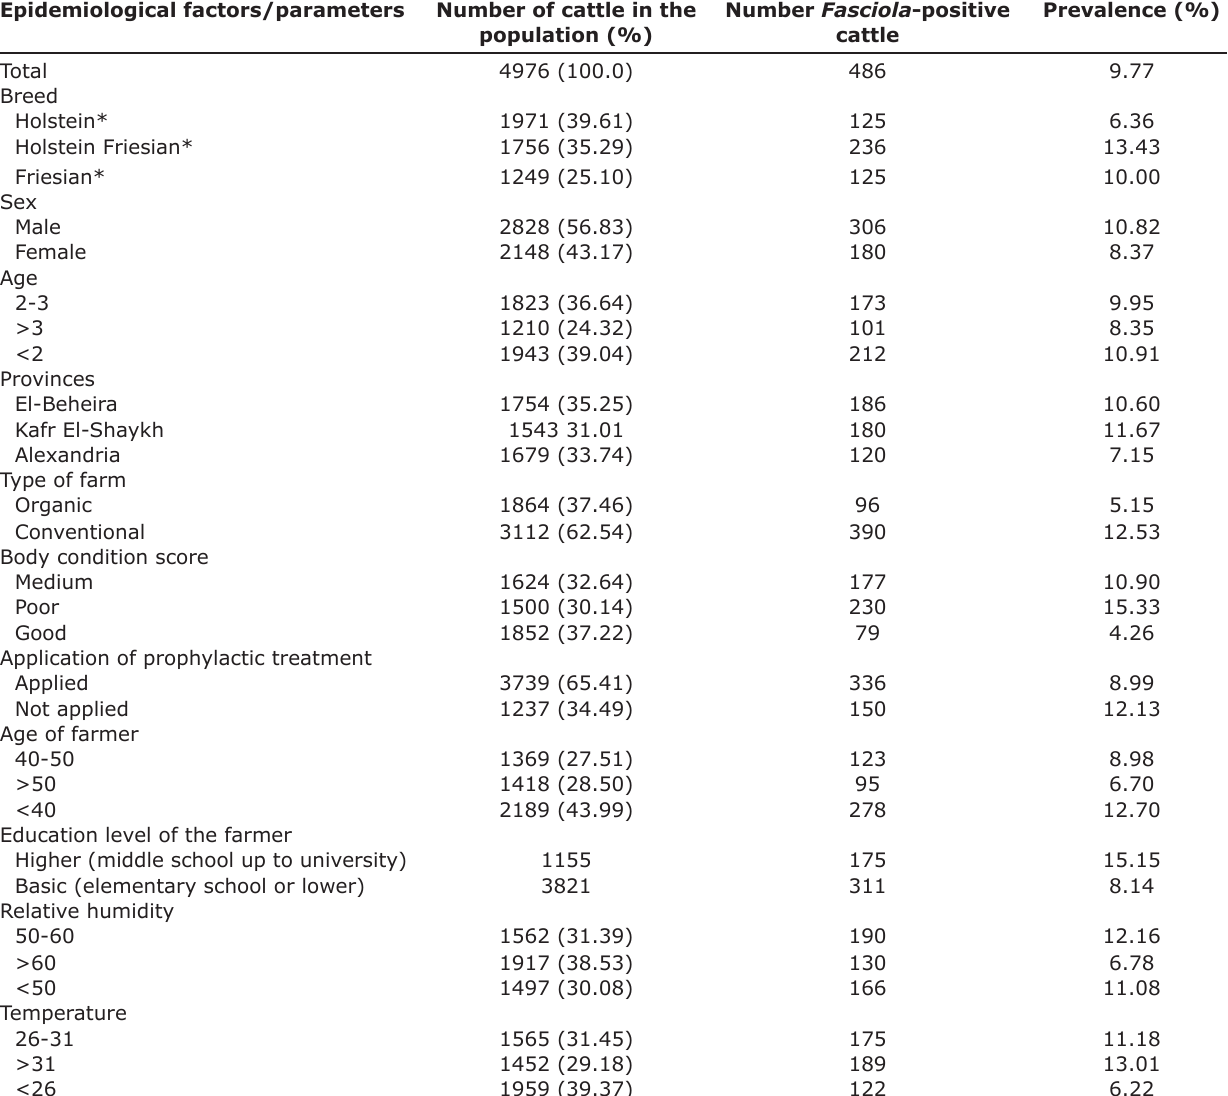
Table-1: Descriptive statistics of the cattle population and prevalence of Fasciola infection in relation to the potential risk factors. Epidemiological factors/parameters